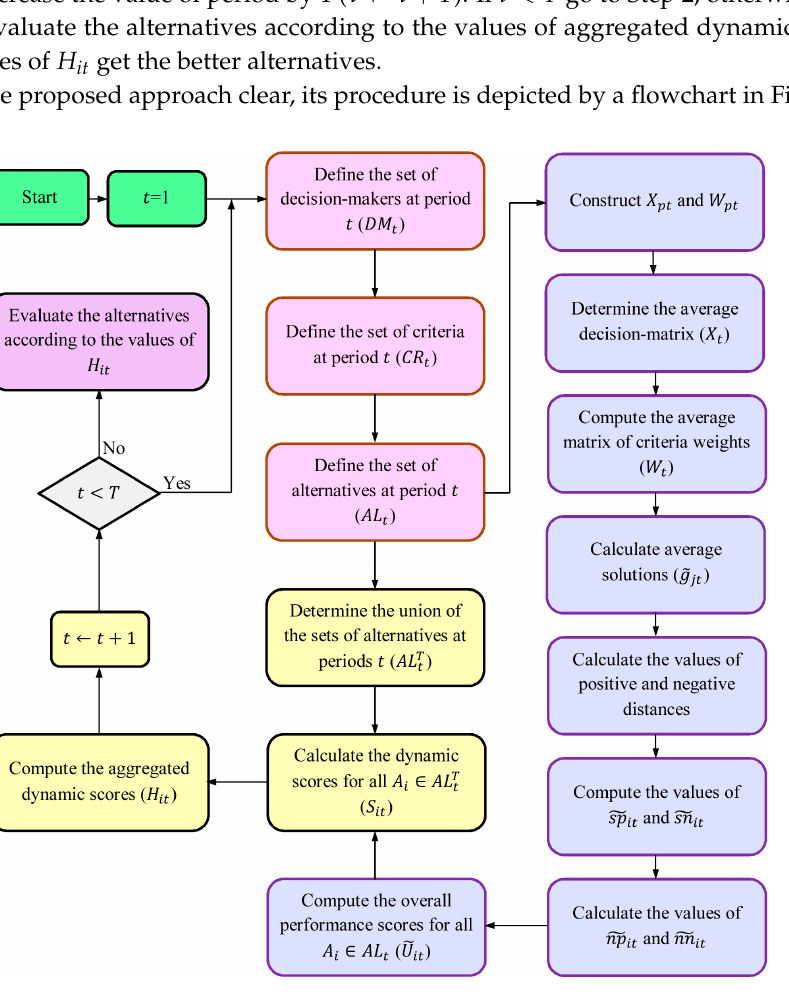
Figure 2. The flowchart of the proposed approach.